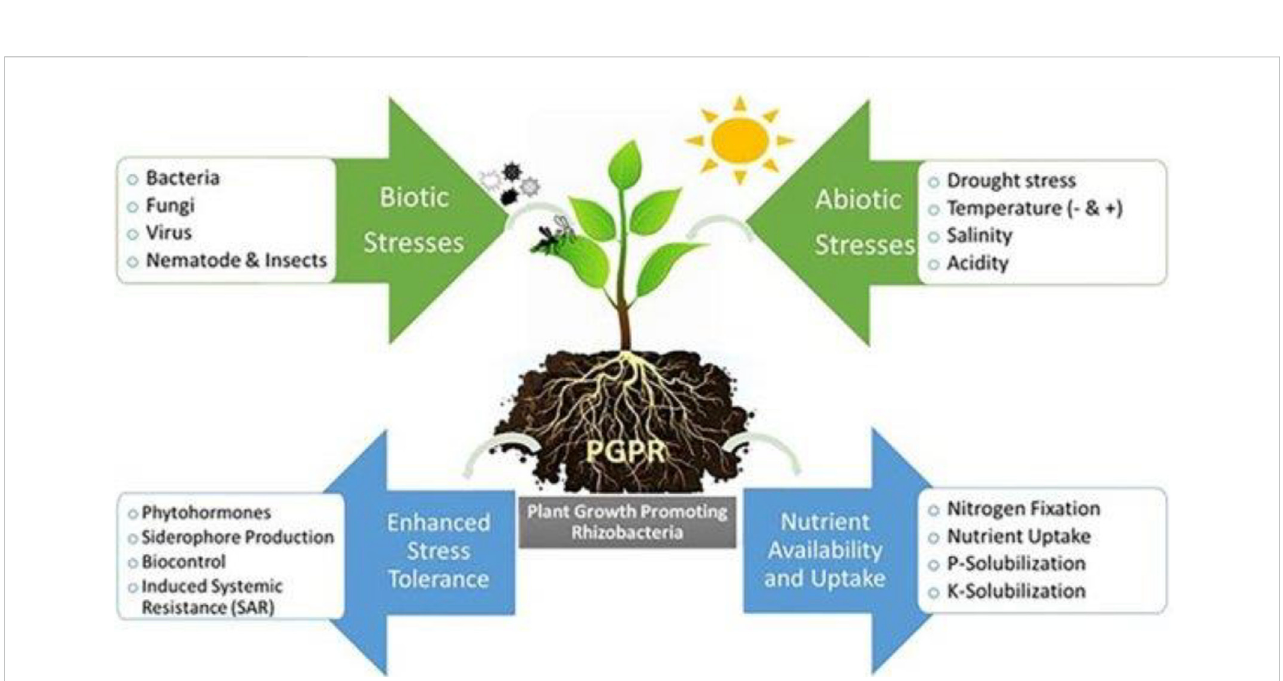
FIGURE 8 PGPR and the interaction of plants in the rhizosphere (Shah et al.,